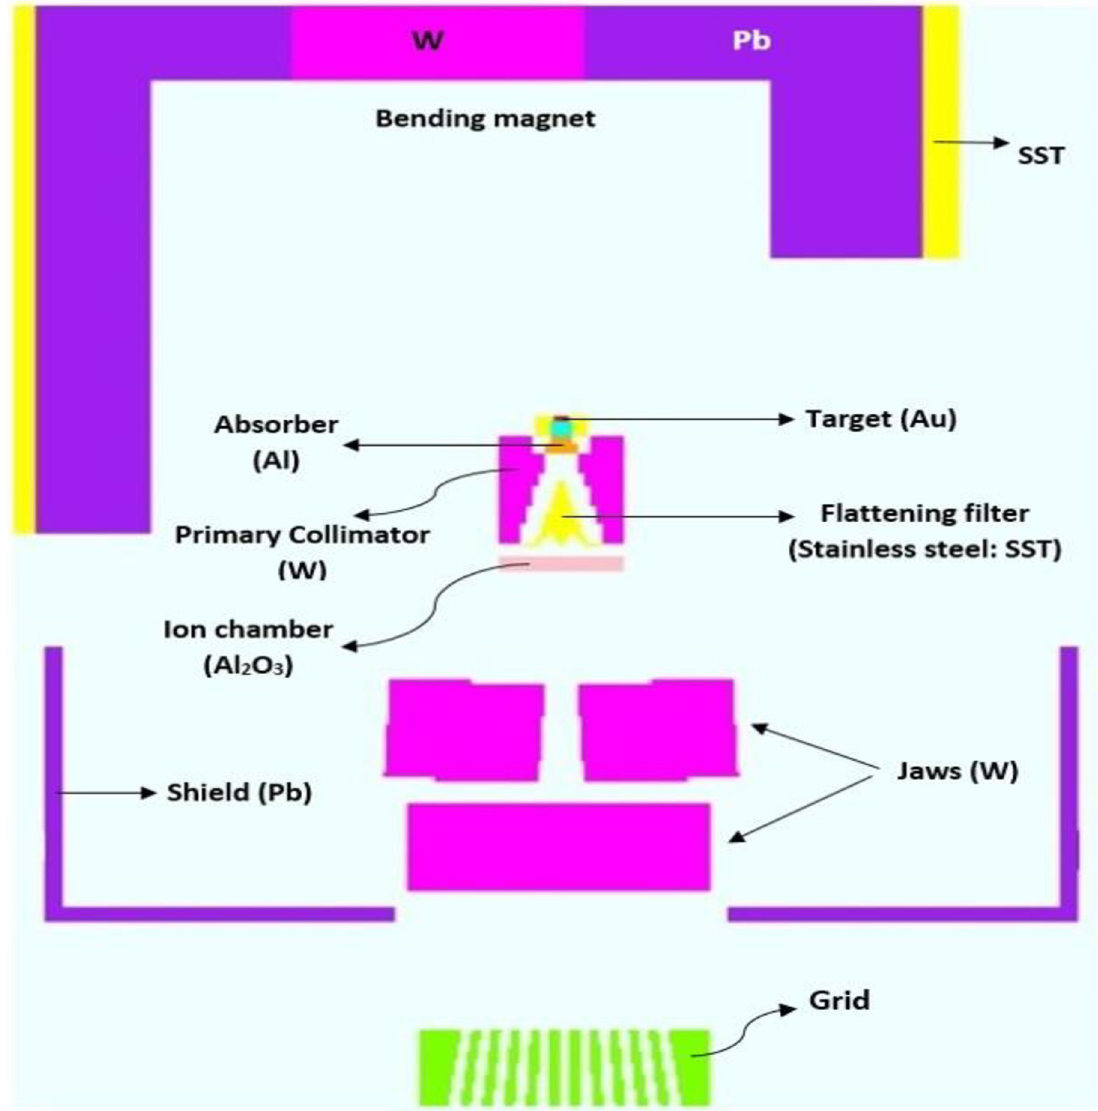
Fig 1. Siemens Primus in 15 MV mode simulated by MCNPX 1